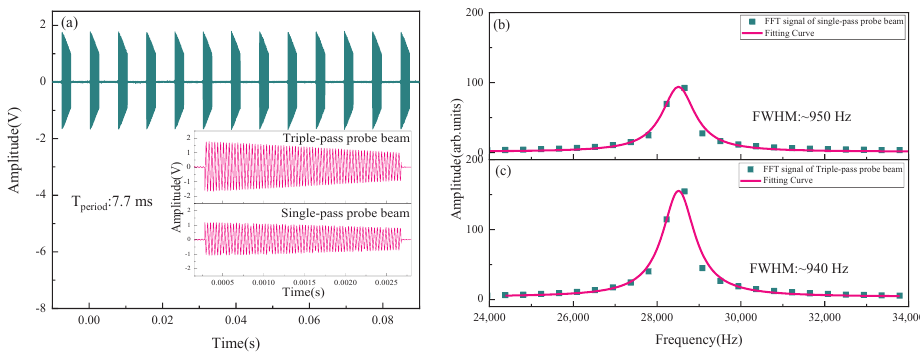
Figure 7. ( a ) Output signal of the balanced differential photodiodes (insert: FID signals for the single-pass and the triple-pass probe beam cases in the same period); ( b , c ), FFT of FID signals for the single-pass and the triple-pass probe beam cases in one